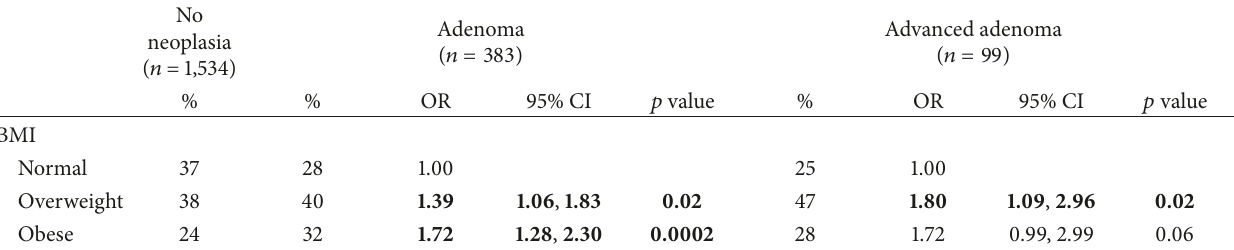
Table 2: OR for A or ADV in overweight or obese persons versus normal weight, unadjusted for other participant characteristics; logistic